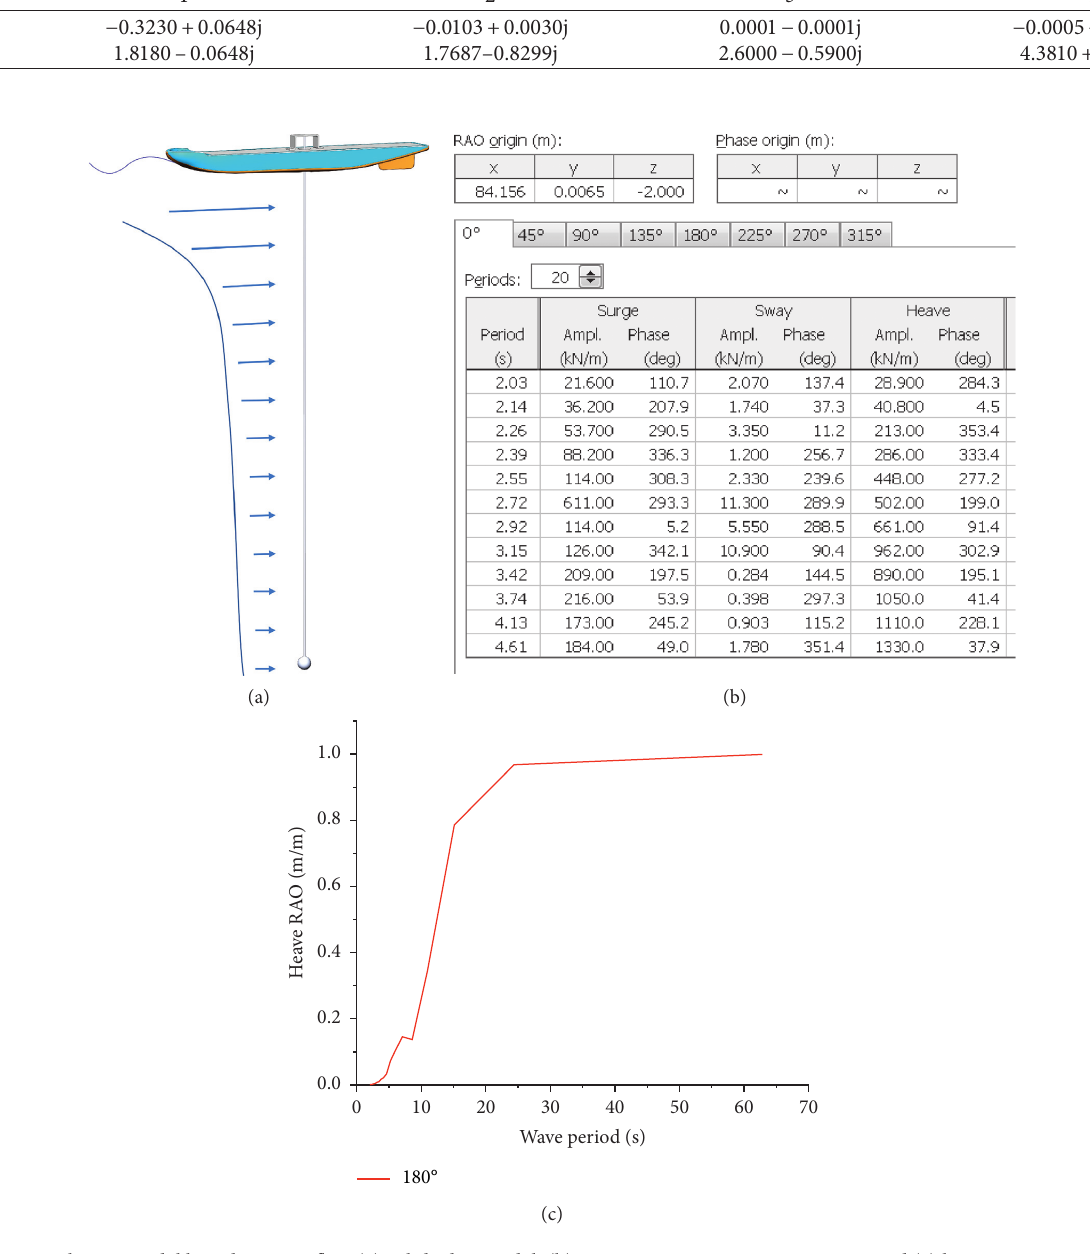
Table 3: Calculation values of A